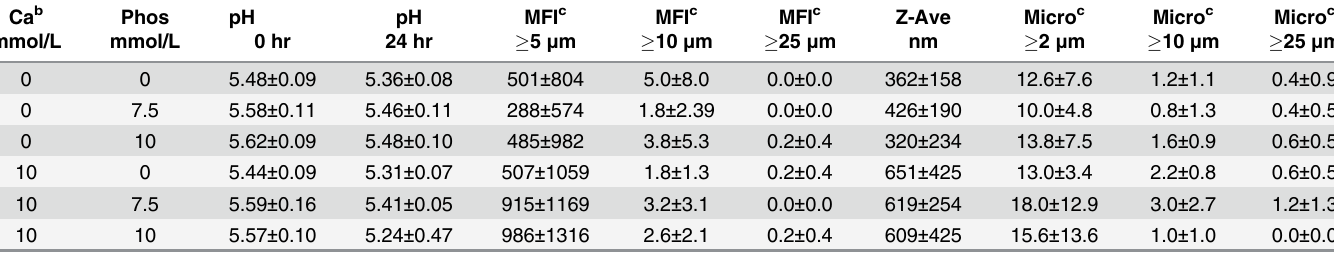
Table 6. Compatibility Studies for 2.5% TrophAmine Solutions a Containing CaCl 2 and Sodium Phosphate With Added Cysteine of 50 mg/dL (Mean ± SD). Ca